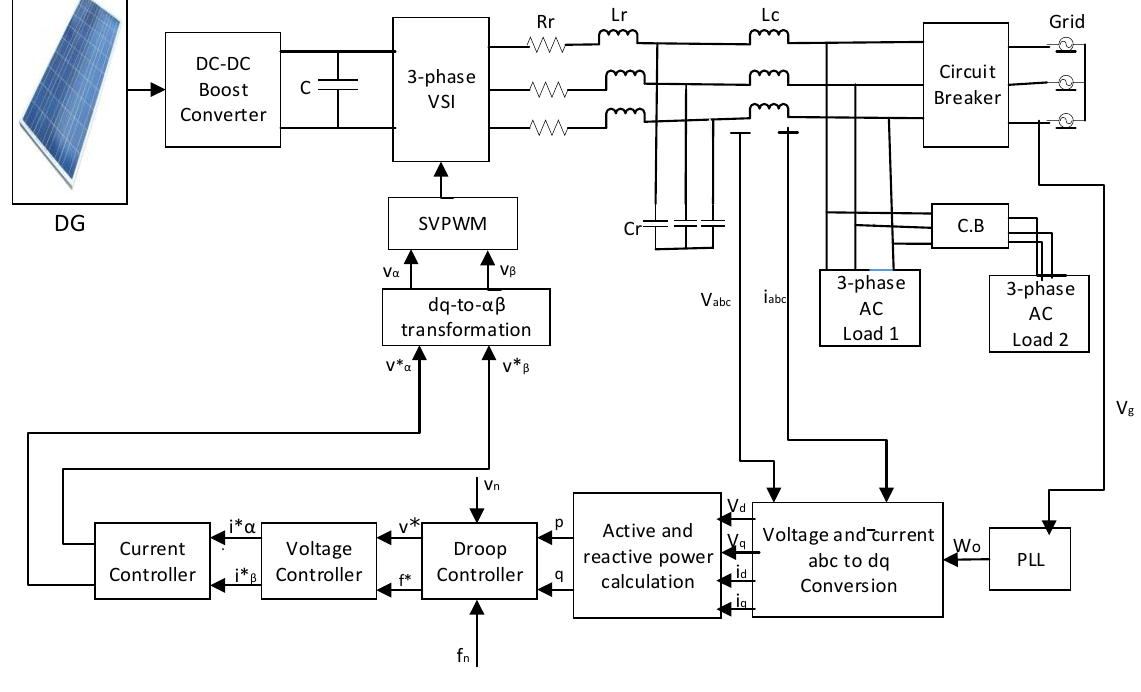
Figure 3. Block diagram for islanded MG.